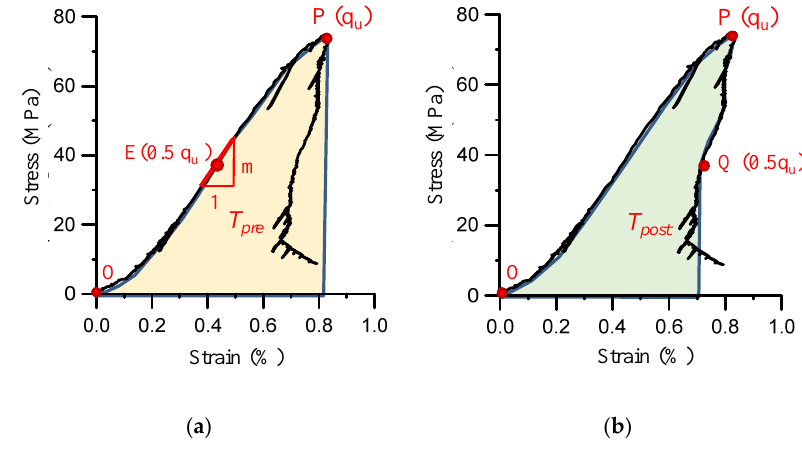
Figure 4. Complete stress ‐ strain curve: ( a ) definition of stiffness (E), strength (q u ), and pre ‐ peak toughness (T pre ); ( b ) definition of post ‐ peak toughness (T post ).